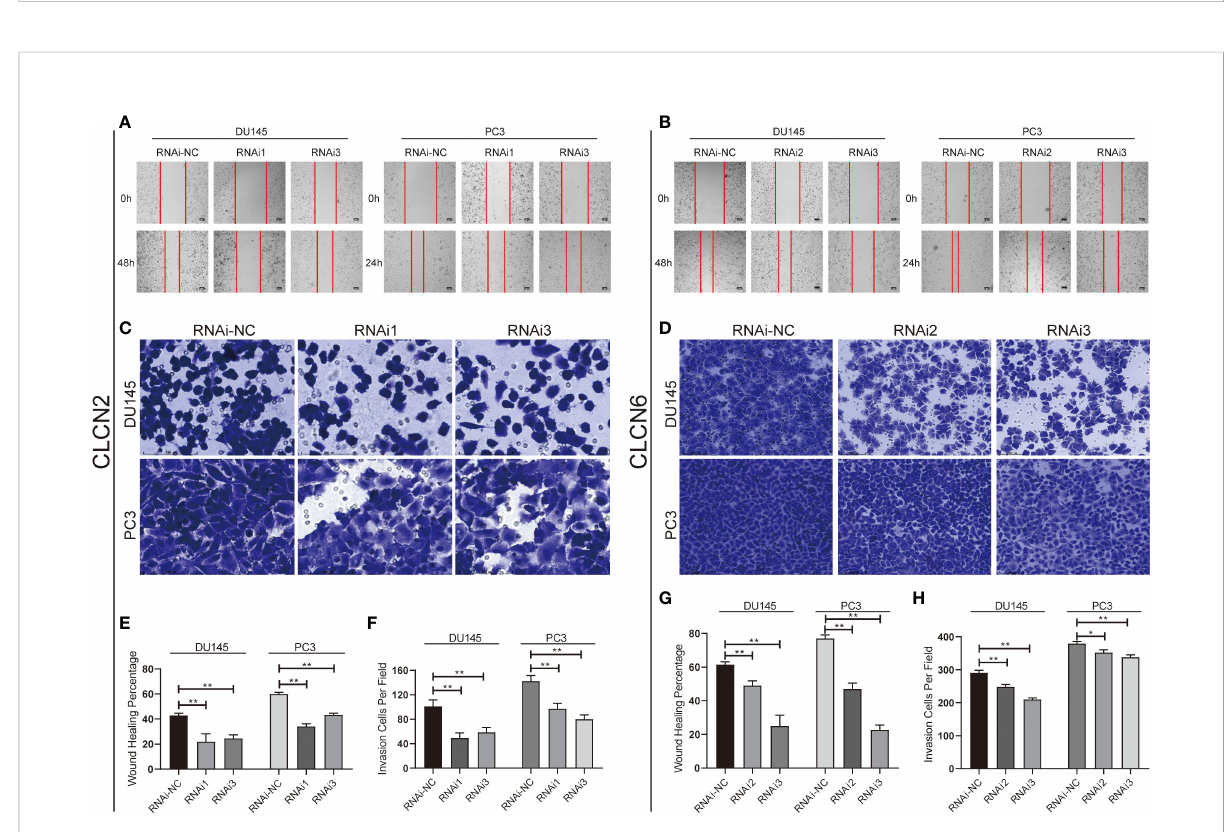
FIGURE 11 Downregulation of CLCN2 or CLCN6 inhibited cell migration and invasion. Downregulation of (A, E) CLCN2 or (B, G) CLCN6 inhibited migration. Downregulation of (C, F) CLCN2 or (D, H) CLCN6 inhibited invasion. * p<0.05 and **